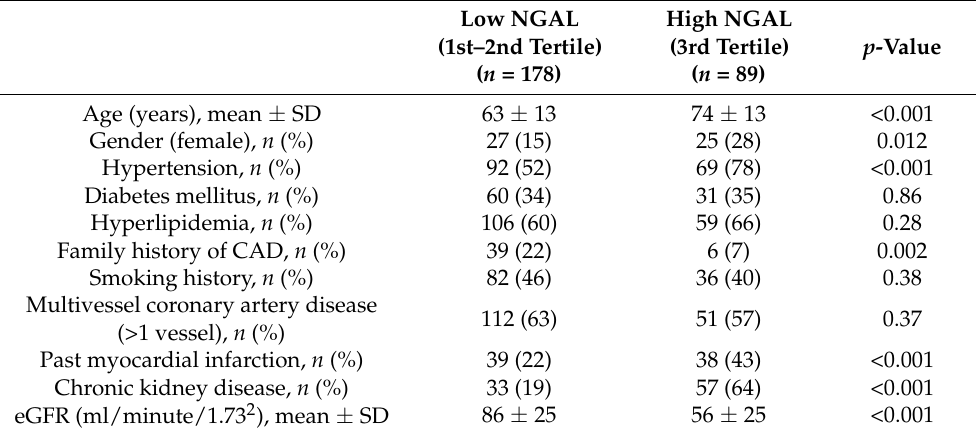
Table 1. Baseline characteristics of 267 STEMI patients stratified by NGAL levels.